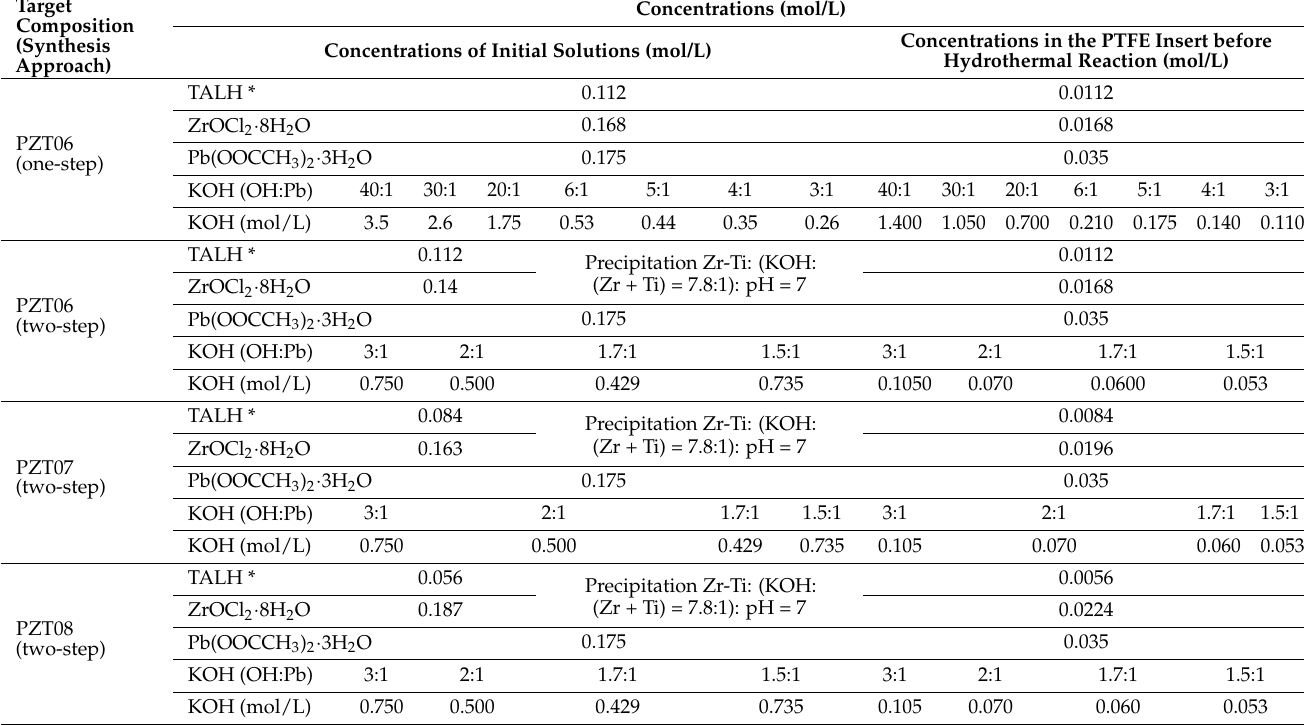
Table 1. Synthesis details in preparation of PbZr x Ti 1-x O 3 (PZT) crystallites with the target x = 0.6 (PZT06), x = 0.7 (PZT07), and x = 0.8 (PZT08) compositions: concentrations of initial solutions before mixing together and concentrations in the autoclave before hydrothermal